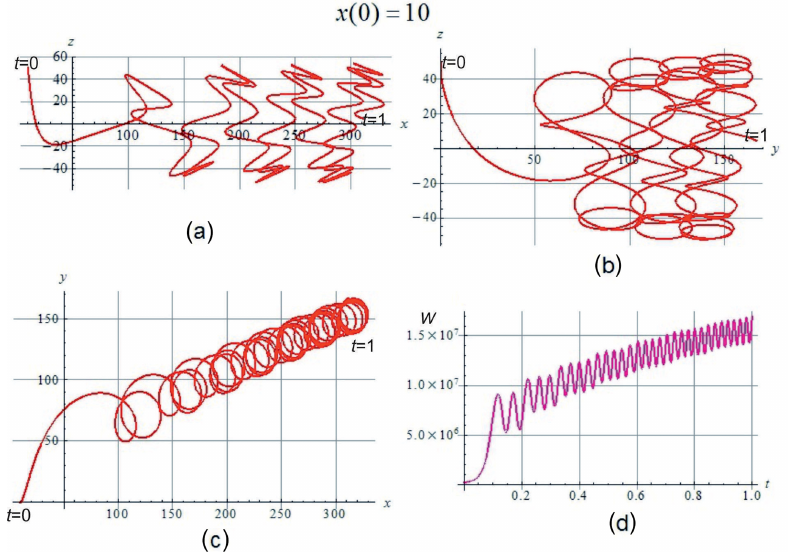
Figure 3. The orbit pattern at x( 0 ) = 10: (a) projected to the (x,z) plane, (b) projected to the (y,z) plane, (c) projected to the (x,y) plane. (d) Time dependence of the kinetic